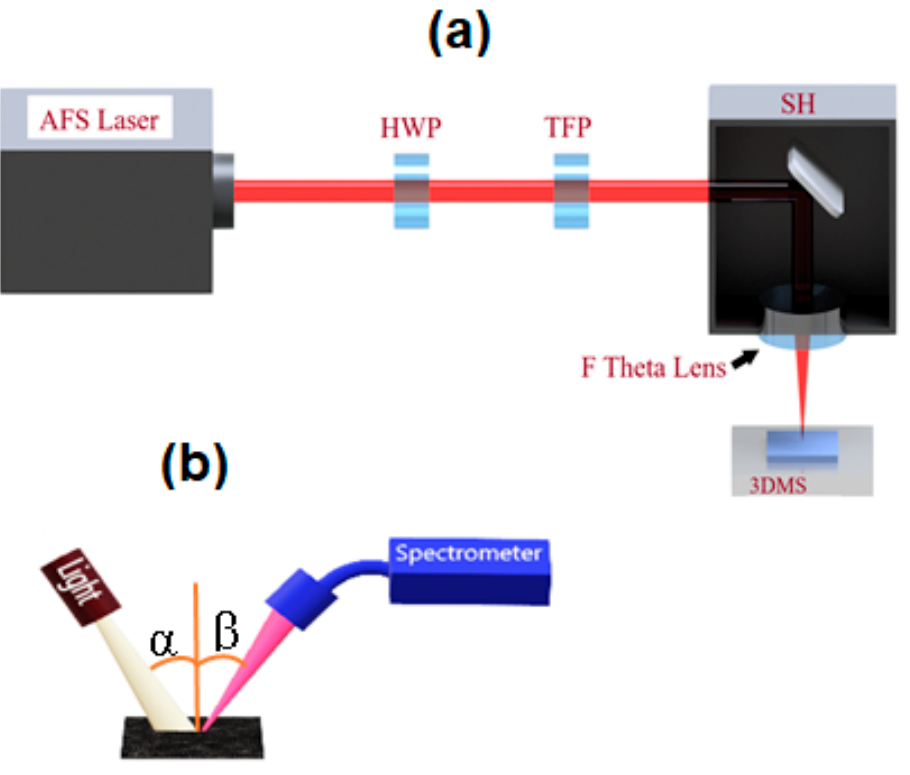
Figure 1. ( a ) Experimental setup for metal surfaces treatment using a femtosecond laser at power 4.5